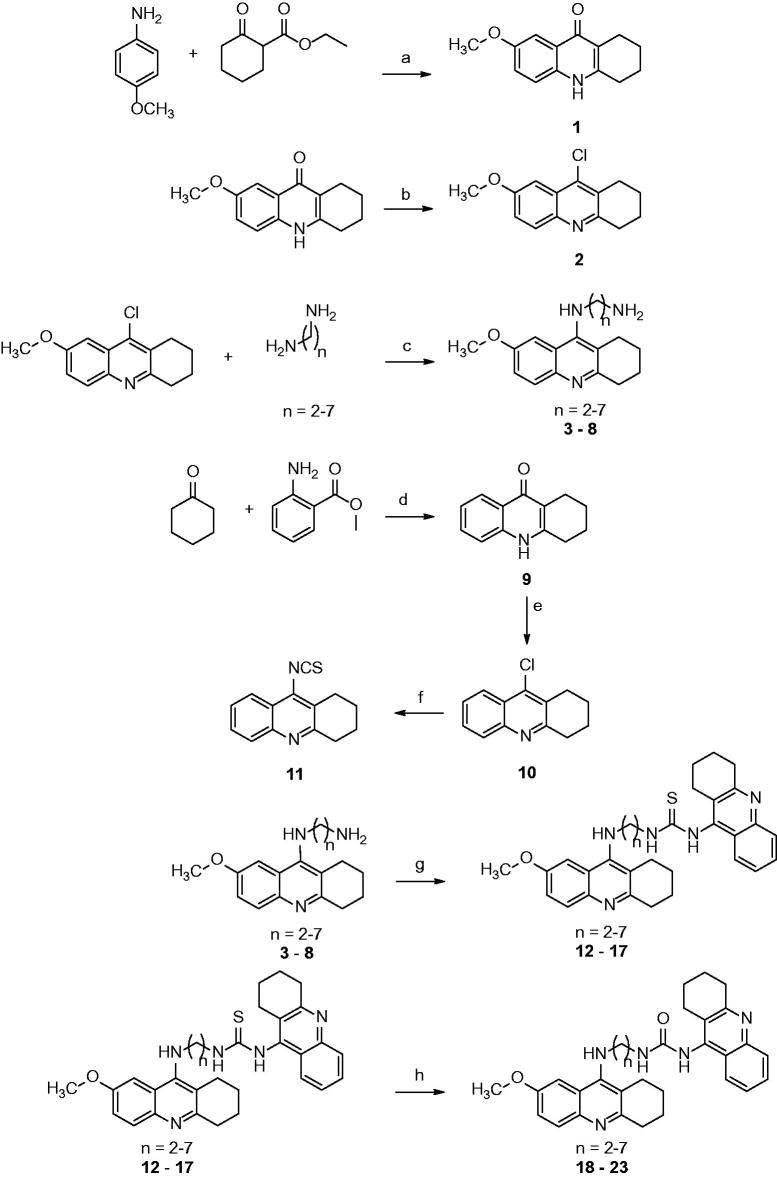
Synthesis of 7-MEOTA-THA thioureas 12–17 and ureas 18–23. Conditions: (a) Dean–Stark trap, toluene, reflux 8 h; diphenylether, 220°C 30 min; (b) POCl3, reflux 1 h; (c) phenol, 130°C, 2–4 h; (d) P2O5, N,N-dimethylcyclohexylamine, 170 °C, 4 h; (e) POCl3, reflux 1 h; (f) AgSCN, dry toluene, reflux overnight; (g) 11, CH2Cl2, RT, 48 h; (h) 2,4,6-trimethylbenzonitrile N-oxide, CH2Cl2, RT, 48 h.